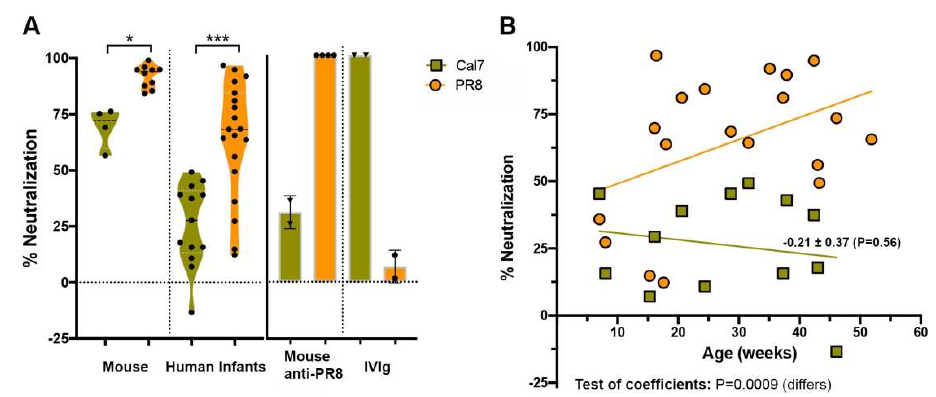
Figure 6. Inhibition of H1N1 IAV by the saliva of human infants. ( A ) A / California / 07 / 2009 (Cal7) or PR8 virus (5000 PFU) were added to untreated mouse or human infant saliva and the percentage neutralized calculated as described for Figure 2. Inhibition by PR8 hyper-immune mouse sera or intravenous immunoglobulin (IVIg) prepared from 2013 human blood donors (0.05 mg / mL) were included as controls ( n = 2–4 replicate samples). Violin plots depicting the mean of each group and probability density of the data at di ff erent values are shown and represent the results of 4–10 independent experiments from pooled mouse saliva or at least triplicate samples from 13–19 individual human infants. ( B ) Linear regression analysis performed on untreated saliva against PR8 and A / California / 07 / 2009 viruses. Data-points represent the means of 13–19 untreated individual human infant saliva samples tested at least in triplicate. Indicated for the line of best fit for Cal7 are the regression coe ffi cient ± standard error ( P value indicative of the goodness of fit of data to the line). Below the figure, the results of tests for similarity of the slopes of the regression lines for PR8 (Figure 5) and Cal7 are indicated.